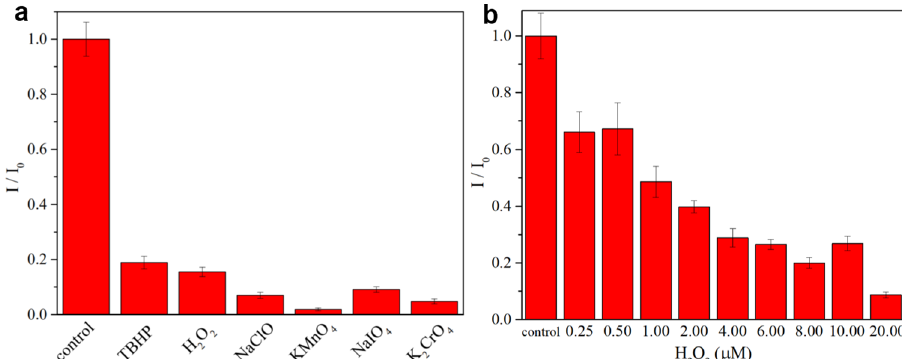
Fig. 8 Ef fi cient response of HQTPE to oxidants. a Relative fl uorescence intensity at 462nm of 10 μ M HQTPE in water before and after the addition of 10 μ M oxidants or b H 2 O 2 at various concentrations. I 0 is the fl uorescence intensity of 10 μ M HQTPE in water at 462nm (control) and I is the corresponding fl uorescence in the presence of testing species with gradient concentrations. Error bars show SDs of three independent